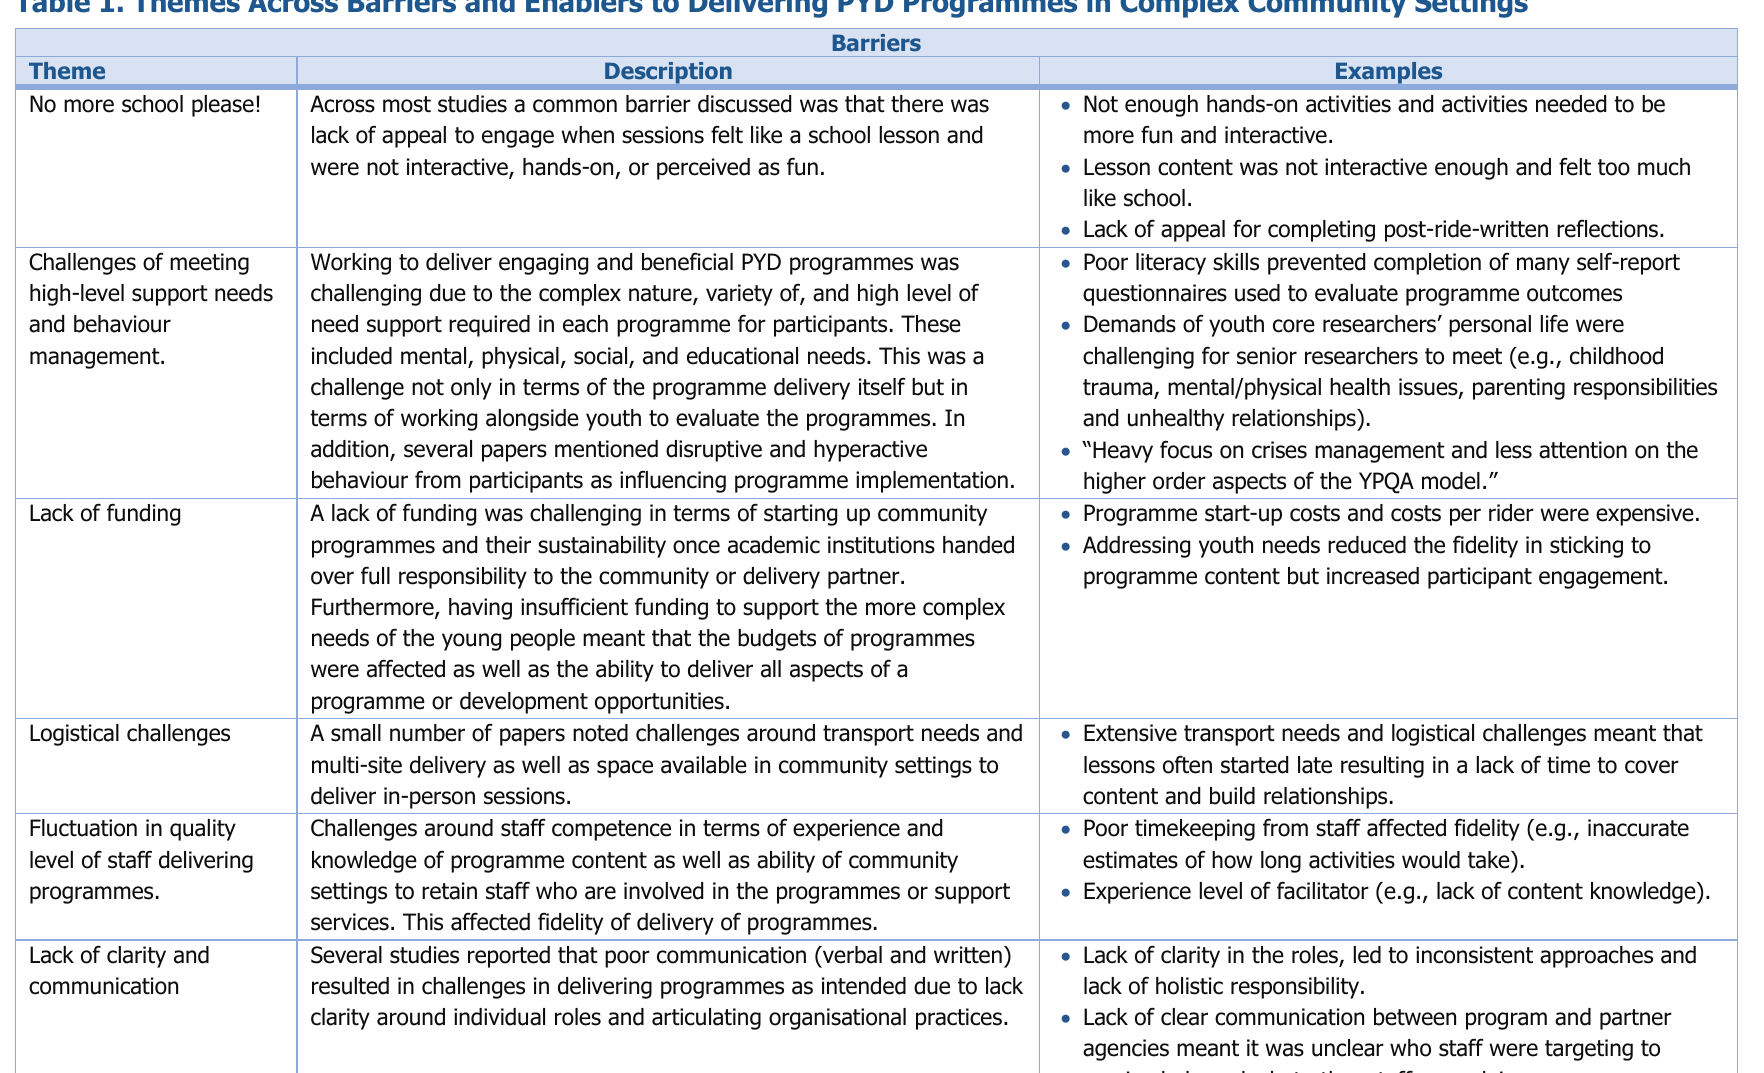
Table 1. Themes Across Barriers and Enablers to Delivering PYD Programmes in Complex Community